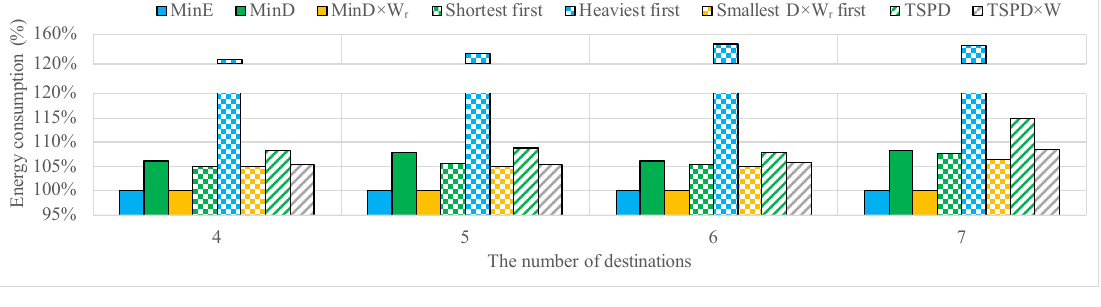
( a ) Average energy consumption comparison on real roads.